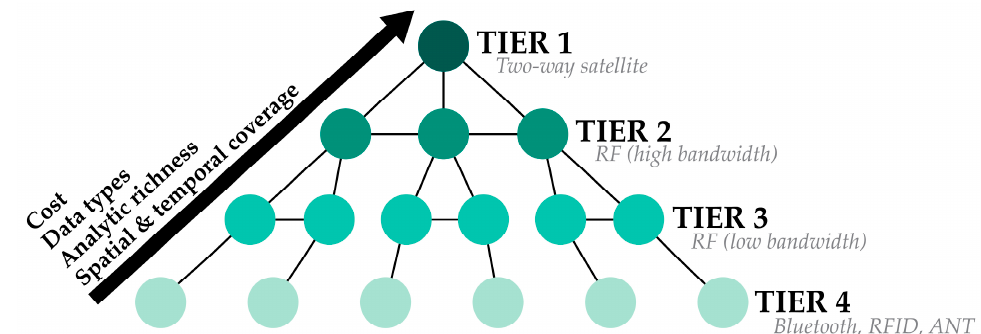
Figure 15. Conceptual model for hierarchical data collection, processing and communication in natural resources. In the lowest tier (Tier 4), data is collected from many resources and transmitted to the next tier (Tier 3) at very short ranges. At higher tiers (Tier 2 and 1), the number of resources decreases, but requisite bandwidth and range increases, as large amounts of data must be summarized and communicated across longer